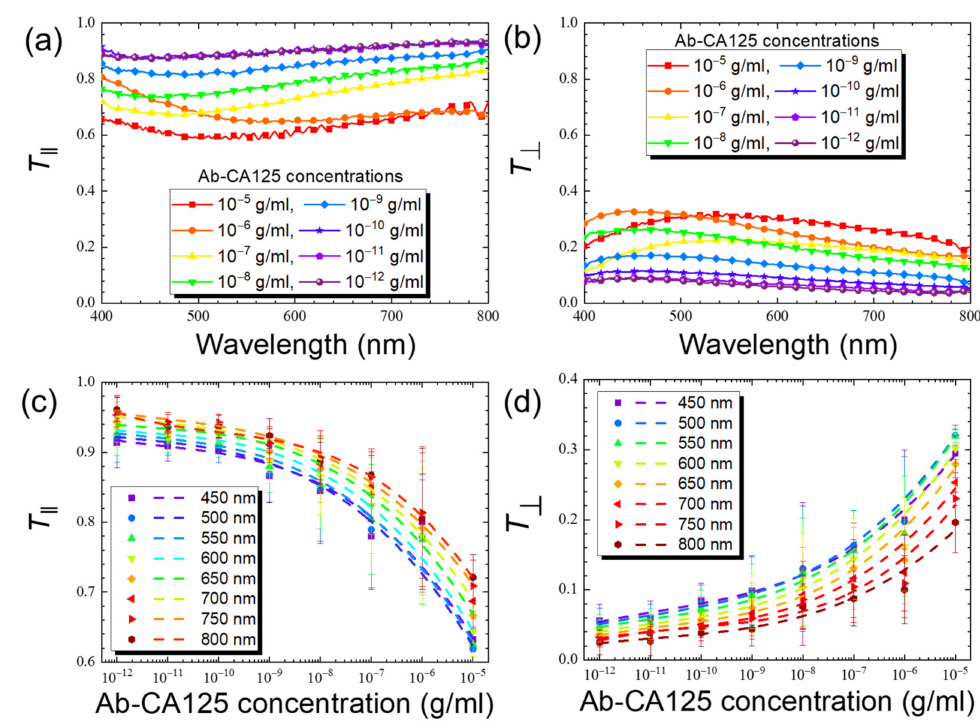
Figure 7. Reduced transmission data of LCLC with 14-wt% DSCG in the presence of the anti-CA125 antibody at various concentrations ranging from 10 − 12 to 10 − 5 g/mL. The reduced transmittance parameters ( a ) T (cid:107) and ( b ) T ⊥ in the wavelength range of 400–800 nm at various antibody concen- trations and ( c ) T (cid:107) and ( d ) T ⊥ plotted against antibody concentration at selected wavelengths of 450, 500, 550, 600, 650, 700, 750, and 800 nm for quantitative purpose. T (cid:107) ( T ⊥ ) corresponds to the measurements with parallel polarizers (crossed polarizers) for the spectrometric detection. Error bars represent standard deviations ( n ≥ 3).